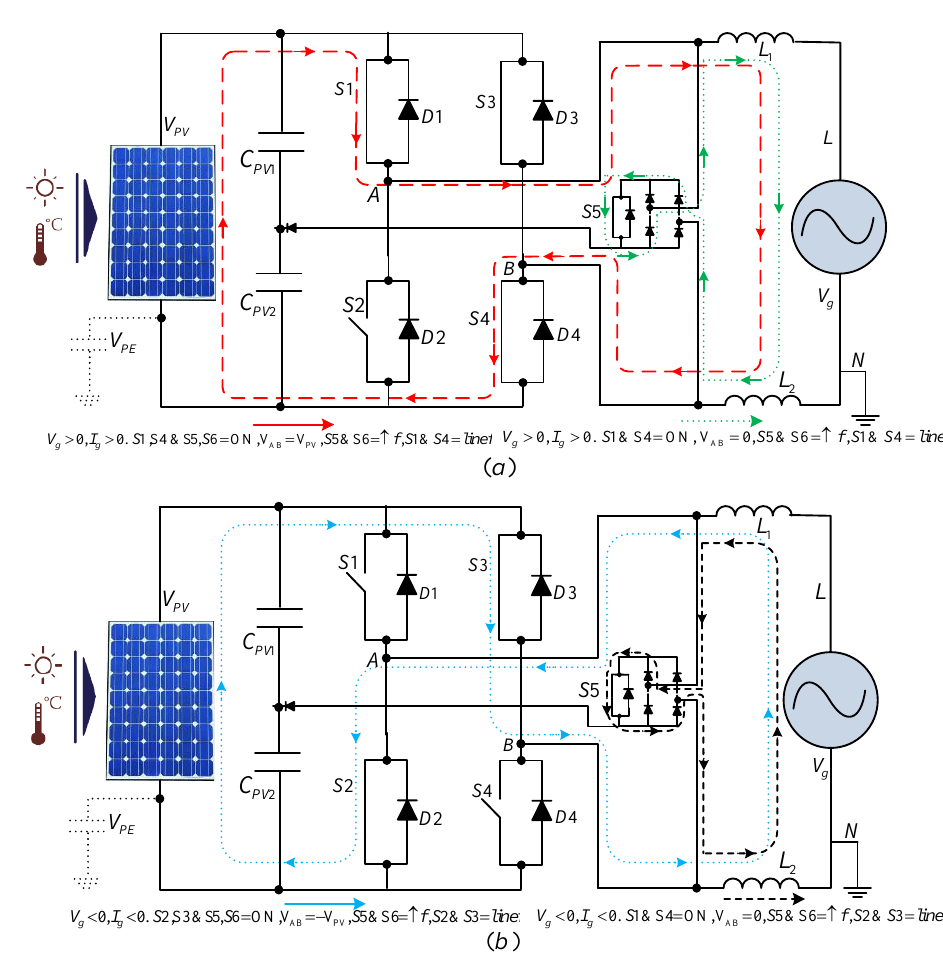
16 of 33 Figure 15. Schematic diagram of the FB-ZVR inverter [43,56]. I. Advantages For FB-ZVR, the following points were noted: (a) the core losses are lower due to unipolar voltage variation i.e. (0 → +𝑉 𝑃𝑉 → 0 → −𝑉 𝑃𝑉 → 0) ; (b) because of a lower switching frequency in one leg, and no exchange of reactive power between C PV and L 1(2) during zero voltage, its efficiency is higher, up to 96%; (c) The EMI filtering requirement and the leakage current peaks is lower as 𝑉 𝑃𝐸 has no switching frequency component and only grid frequency component is present [56]. II. Disadvantages Its disadvantages are: (a) addition of four extra diodes and one more switch; (b) filter losses increases, as bipolar output is obtained during deadtime clamping.